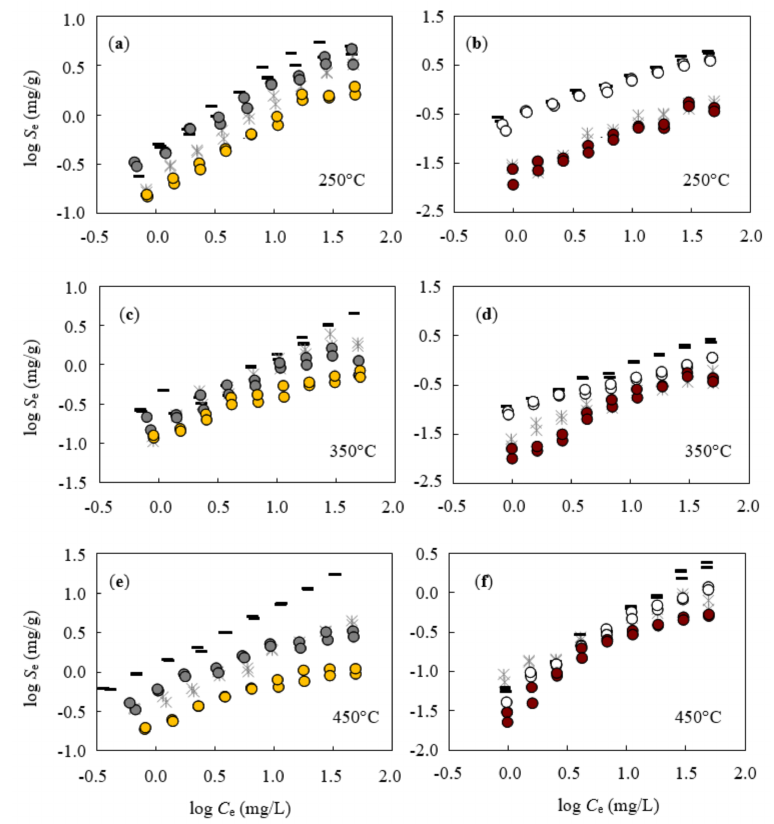
Figure 4. Sorption isotherms on various biochars at pH 4 (thin fork, horizontal mark) and pH 7 (circular rings). The grey and yellow circular rings represented BA- and PS-derived biochars produced at 250 ( a ), 350 ( c ) and 450 ◦ C ( e ); the white and red circular rings represented CE- and LI-derived biochars produced at 250 ( b ), 350 ( d ) and 450 ◦ C ( f ),